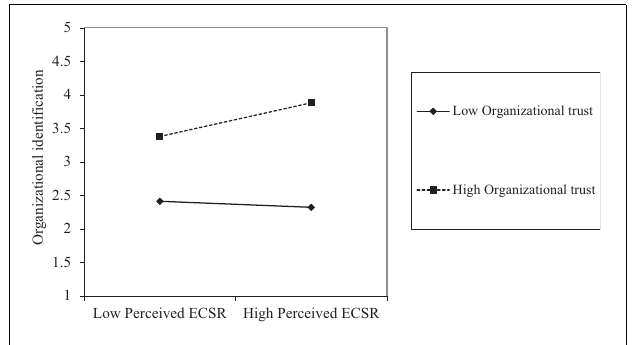
FIGURE 2 | Interaction of perceived environmental corporate social responsibility (ECSR) and organizational trust on organizational identification.